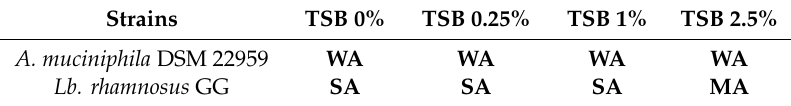
Table 4. Biofilm formation of A. muciniphila DSM 22959 and Lb. rhamnosus GG after incubation at 37 ◦ C for 24 h in TSB containing di ff erent concentrations of glucose (0%, 0.25%, 1%, and 2.5%). The cut-o ff (OD C ) was defined as the mean OD value of the negative control. Based on the OD, strains were